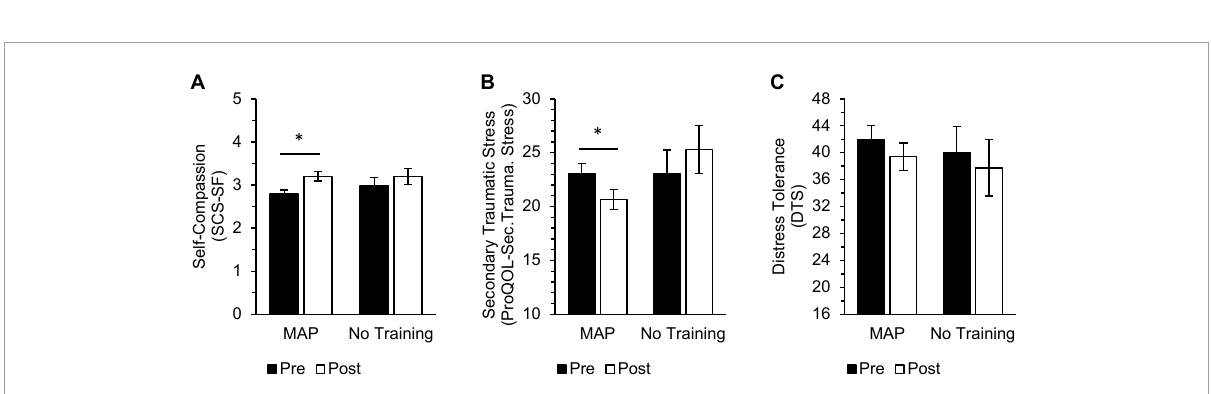
FIGURE5 In the MAP group, post-intervention scores were significantly improved from pre-intervention scores on measures of self-compassion [ (A) SCS-SF] and secondary traumatic stress related to profession [ (B) ProQoL-Secondary Traumatic Stress], while there were no significant differences between pre-intervention and post-intervention scores on these same measures in the No Training group. There were no significant within-group differences in distress tolerance [ (C) DTS]. There were no significant differences between groups at either timepoint. Asterisks indicate significant adjusted p -values. A mean is calculated for the SCS-SF. Scores on the DTS range from 16 to